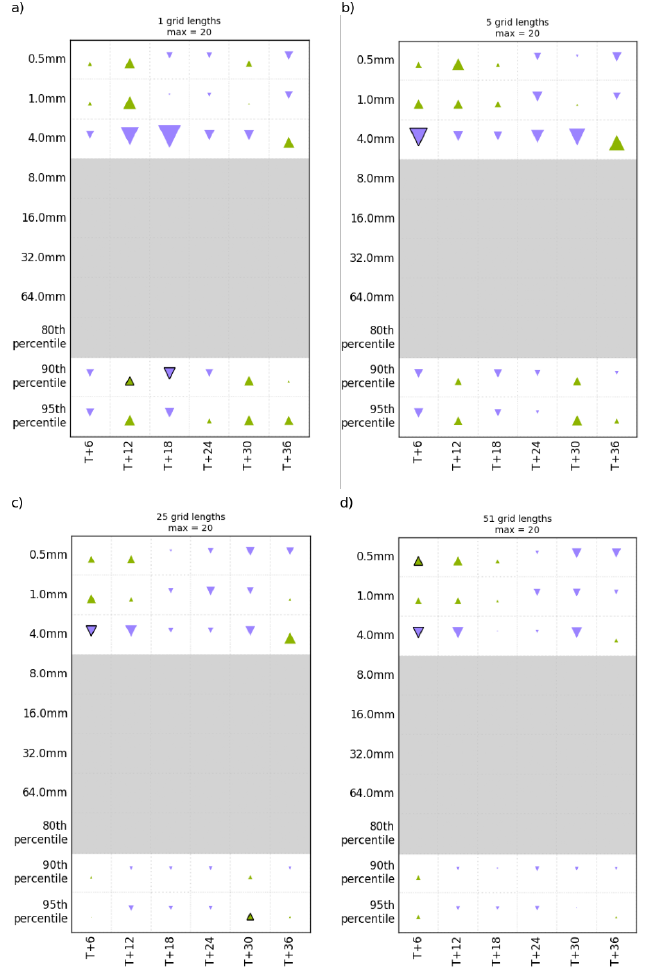
Figure 3. Hinton diagrams illustrating the differences in FSS for 1 h precipitation accumulation on a neighbourhood size of 1 ( a ), 5 ( b ), 25 ( c ), and 51 ( d ) grid lengths for the control and test. Green indicates a positive impact, and purple indicates a negative impact. Statistically significant results are triangles outlined in black.